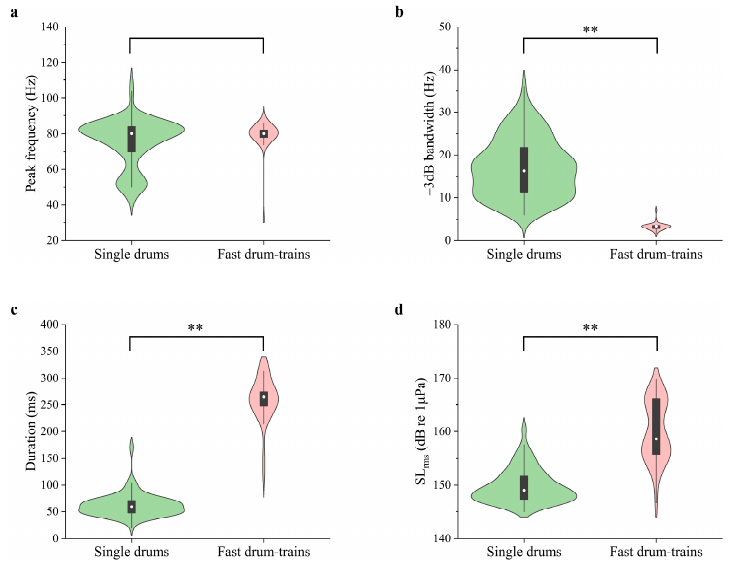
Figure 4. Violin plots of acoustic characteristics of the sounds emitted by the Chinese bahaba: ( a ) peak frequency (PF); ( b ) − 3 dB bandwidth (BW − 3 dB ); ( c ) signal duration (DUR), and ( d ) root-mean-square sound pressure levels (SPLrms, ** p < 0.05).